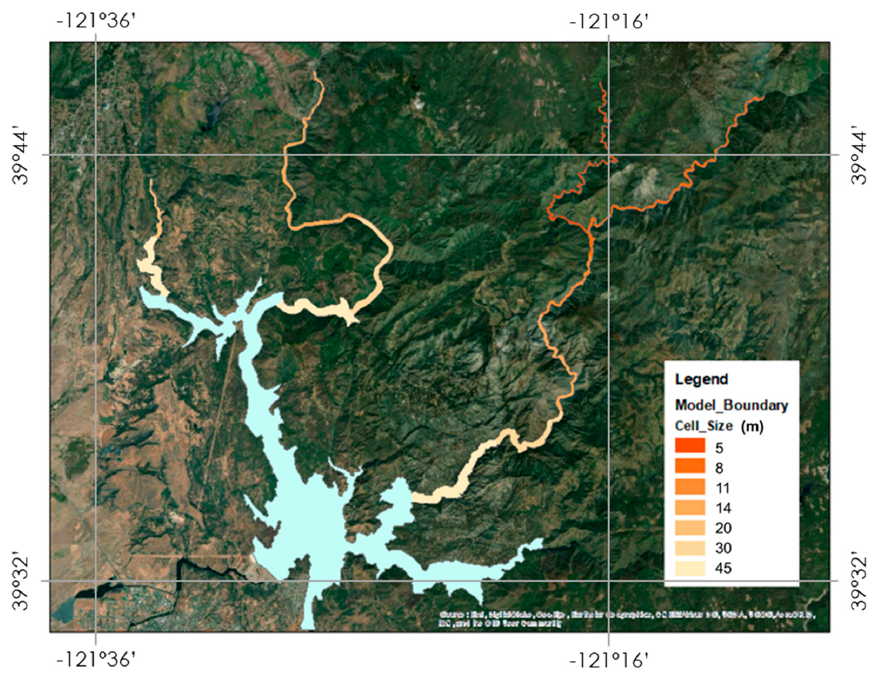
Figure 6. Mesh resolution of the 2D HEC-RAS hydrodynamic model. The hydrologic events with return periods of 1, 2, 5, 25, 50, 100, and 500 years were simulated with the refined 2D HEC-RAS hydrodynamic model. The corresponding dis- charge for the MF Feather River was obtained from the USGS stream gauge; while the torical discharge records. The regression analysis showed a strong correlation of the dis- charge among the rivers within the domain of interest with the correlation coefficient for